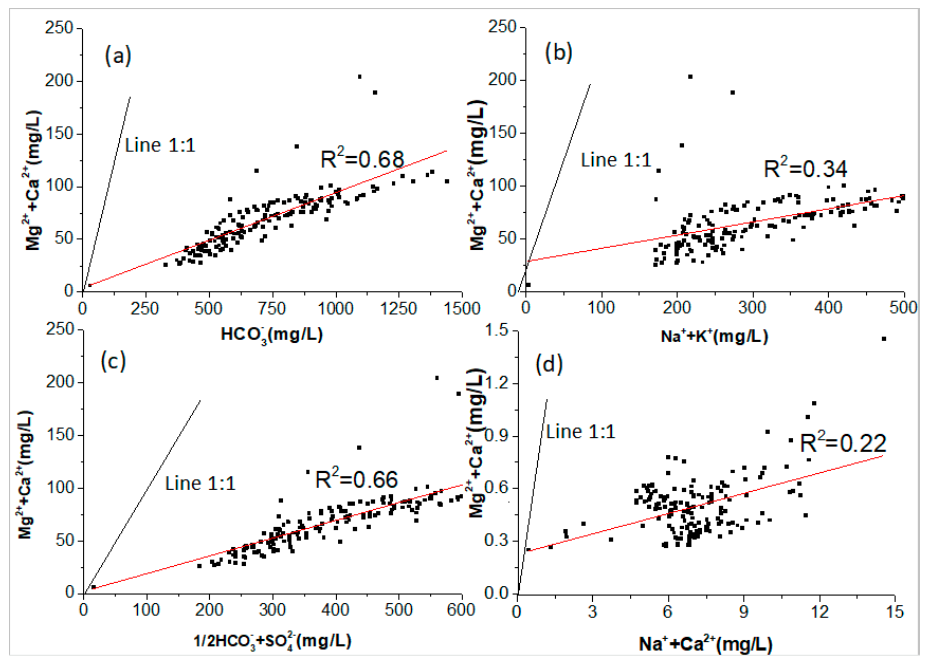
Figure 5. Proportions of the major ions in the runoff of the Dongkemadi River. ( a ) the relationship between the (Mg 2+ /Ca 2+ ) and HCO 3 − ; ( b ) the relationship between the (Mg 2+ /Ca 2+ ) and (Na + /K + ); ( c ) the relationship between the (Mg 2+ /Ca 2+ ) and (1/2HCO 3 − + SO 4 2 − ); ( d ) the relationship between the (Na + /Ca 2+ ) and (Mg 2+ /Ca 2+ ).